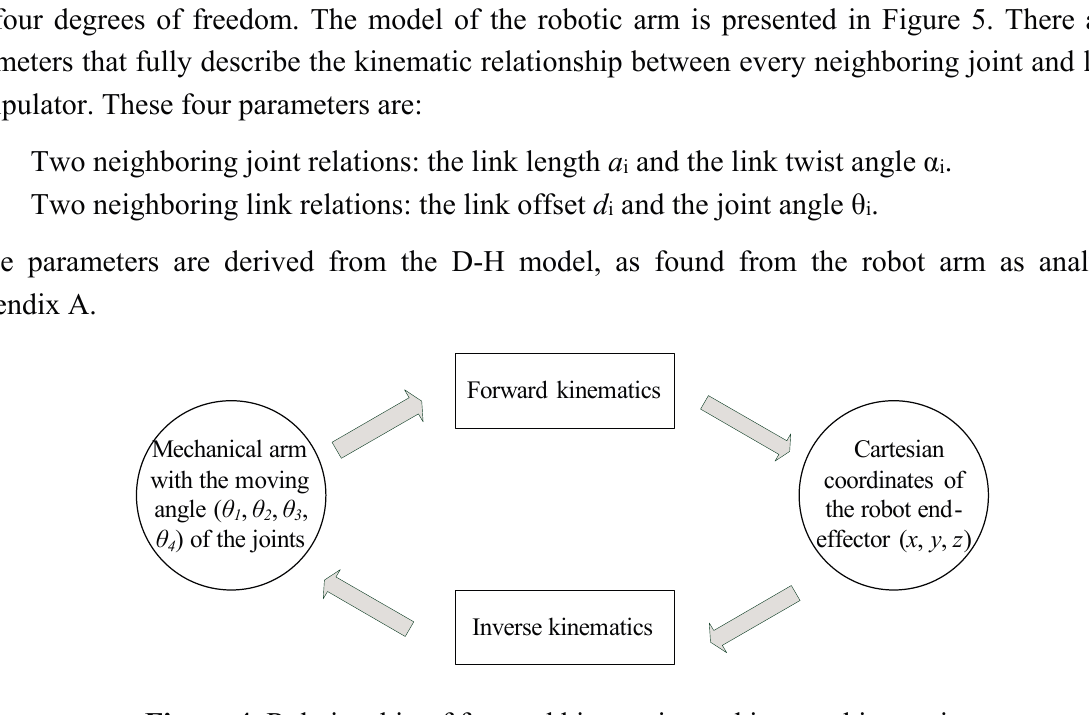
Figure 4. Relationship of forward kinematics and inverse kinematics.